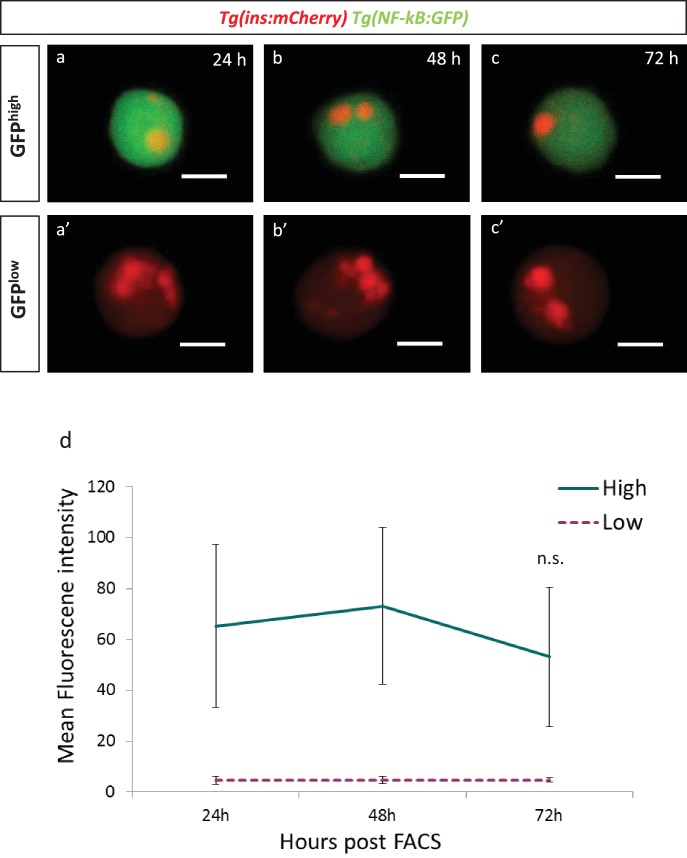
The GFP fluorescence of the transgenic reporterTg(NF-kB:GFP)remains stable for 72 hours in beta-cells.(a,b,c) Beta-cells from Tg(NF-kB:GFP);Tg(ins:mCherry) animals at 3 mpf were FAC-sorted as single cells in 384-well plates and followed over 72 hr. NF-kB:GFPhigh cells at 24, 48 and 72 hr post-FAC-sorting. Scale bar 5 µm. (a’,b’,c’) NF-kB:GFPlow cells at 24, 48 and 72 hr post-FAC-sorting. Scale bar 5 µm. (d) Quantification showing the mean GFP fluorescence intensity of GFPhigh and GFPlow cells (n = 7 GFPhigh cells and n = 5 GFPlow cells).